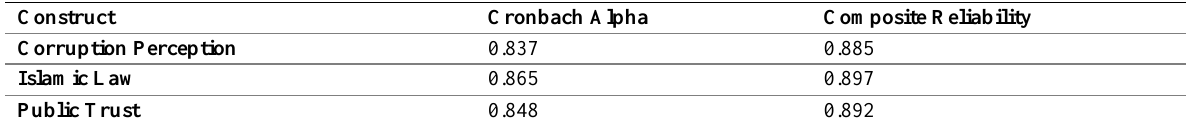
Table 4: Cronbach Alpha Value and Composite